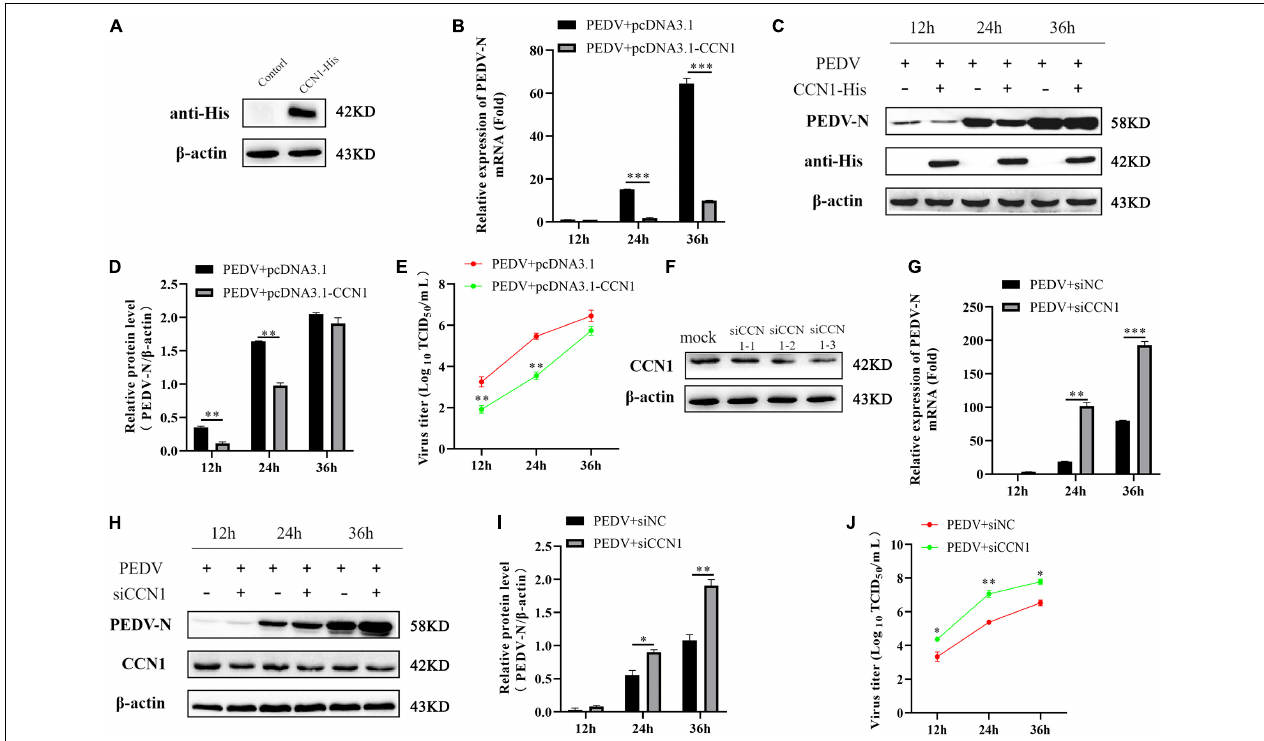
FIGURE 5 | The CCN1 protein to the effect of PEDV replication. (A) Marc-145 cells were transfected with pcDNA3.1-CCN1-his or pcDNA3.1-his vector for 36 h. Western blot detected CCN1 expression efficiency. (B–D) Marc-145 cells were transfected with pcDNA3.1-CCN1-his or pcDNA3.1-his vector for 36 h. PEDV at MOI 1 was used to infect cell for 1 h. Then, cells and supernatant were harvested to evaluate the mRNA and protein expression level of PEDV-N by real-time PCR (B) , Western blot (C) , and densitometric analysis (D) . (E) The supernatant was harvested to assess viral title by TCID 50 . (F) Marc-145 cells were transfected with three siRNA for 48 h, and CCN1 knockdown efficiency was assessed. (G–J) Marc-145 cells were transfected with siNC or siCCN1 for 48 h, and cells were incubated with PEDV at MOI 1 for 1 h. Then, using real-time PCR and Western blot, respectively, detected PEDV-N mRNA (G) , protein expression (H) , and densitometric analysis (I) . TCID 50 was used to examine viral title (J) . The data were performed from three independent experiments. The differences were evaluated using Student’s t -test, and significance differences were denoted by ∗ p < 0.05, ∗∗ p < 0.01, and ∗∗∗ p <